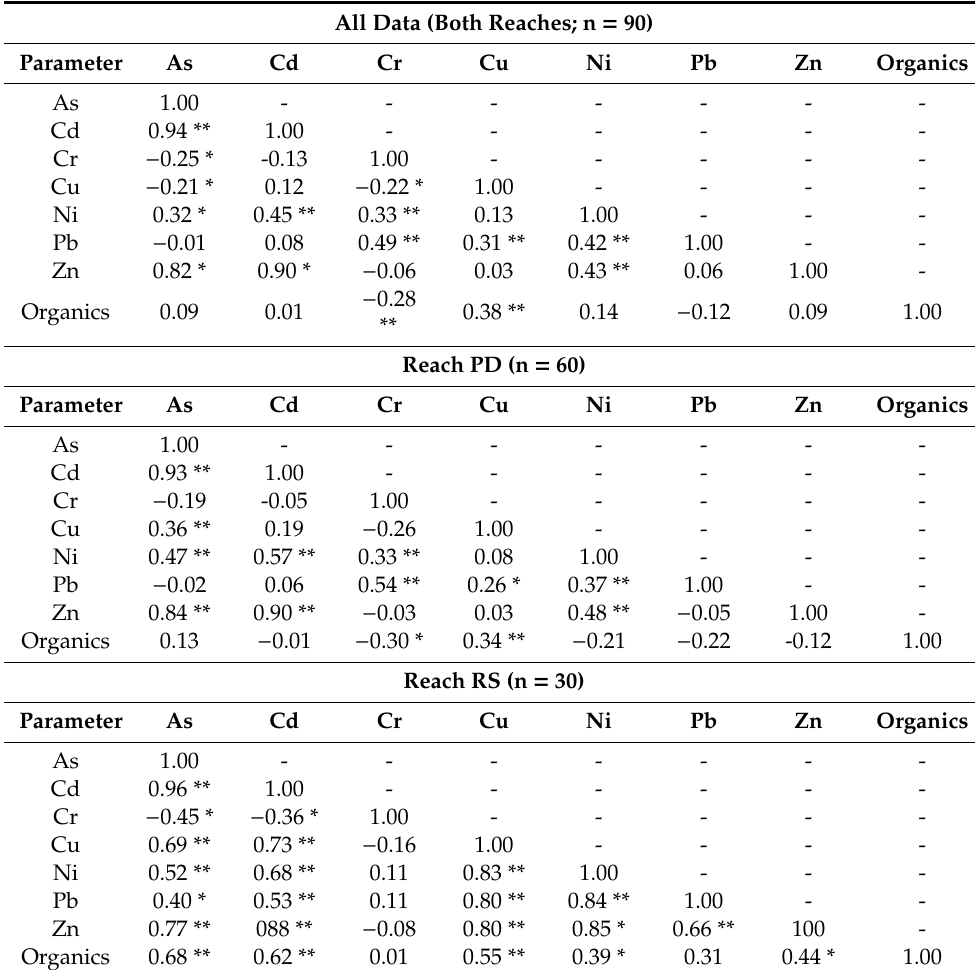
Correlations between trace metals and organic matter percentage for total dataset; concentrations determined for < 63 µ m